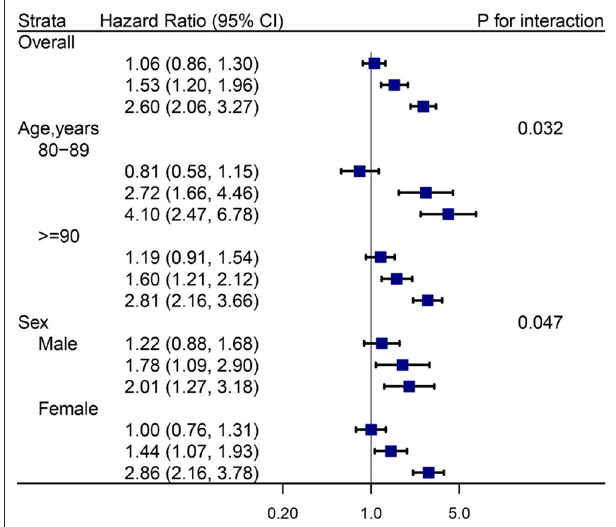
FIGURE 4 | Hazard ratios (HRs) for the combined associations of anemia and cognition impairment with mortality according to age and sex subgroups. All models were adjusted for age (not in age subgroup) and sex (not in sex subgroup), education, marital status, ethnicity, current smoker, current drinker, body mass index, cognitive impairment, albumin, high-sensitivity C-reactive protein, and chronic conditions (hypertension, diabetes mellitus, and chronic kidney disease). the estimated HRs for each group are compared with individuals who did not have anemia and cognition impairment ( HR = 1.0, not